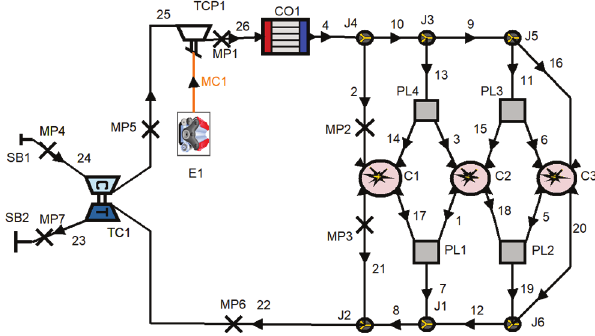
Fig. 3. Model of the engine with the Garrett GT-2560R turbocharger connected in series with the Eaton TVS R410 mechanical compressor The so-called offset, i.e. a phase shift between the en-